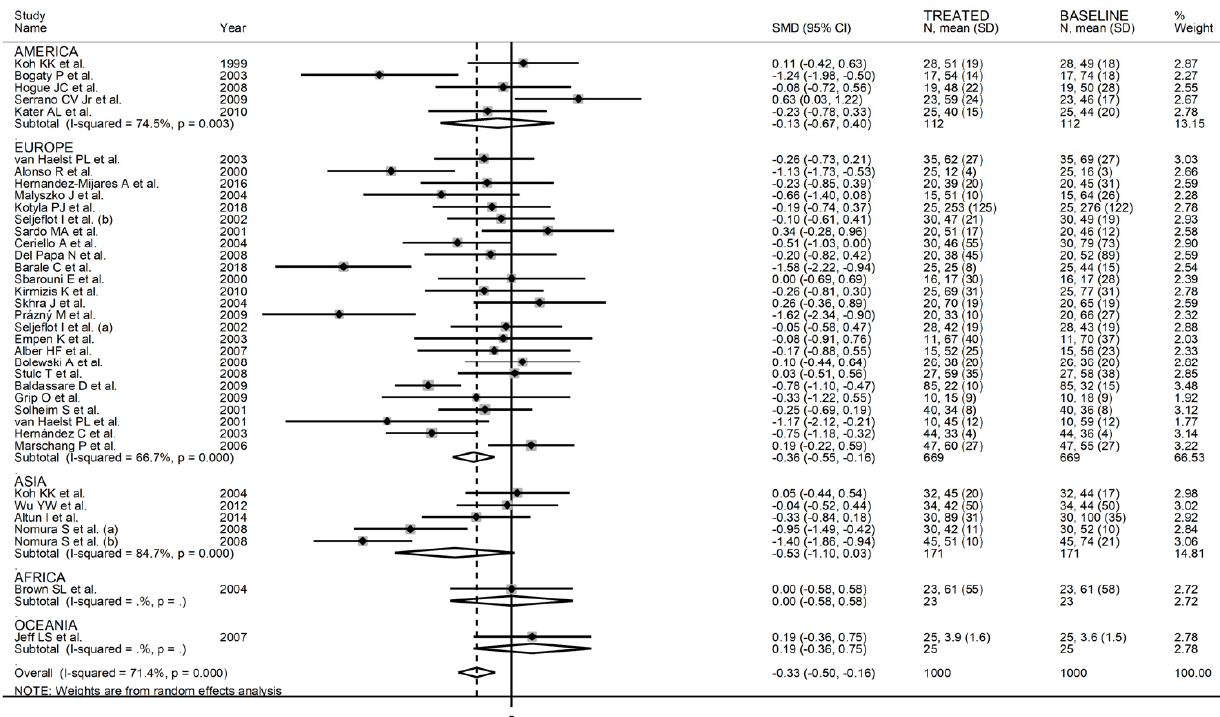
Figure 15. Forest plot of E-Selectin concentrations before and after statin treatment according to individual agents.